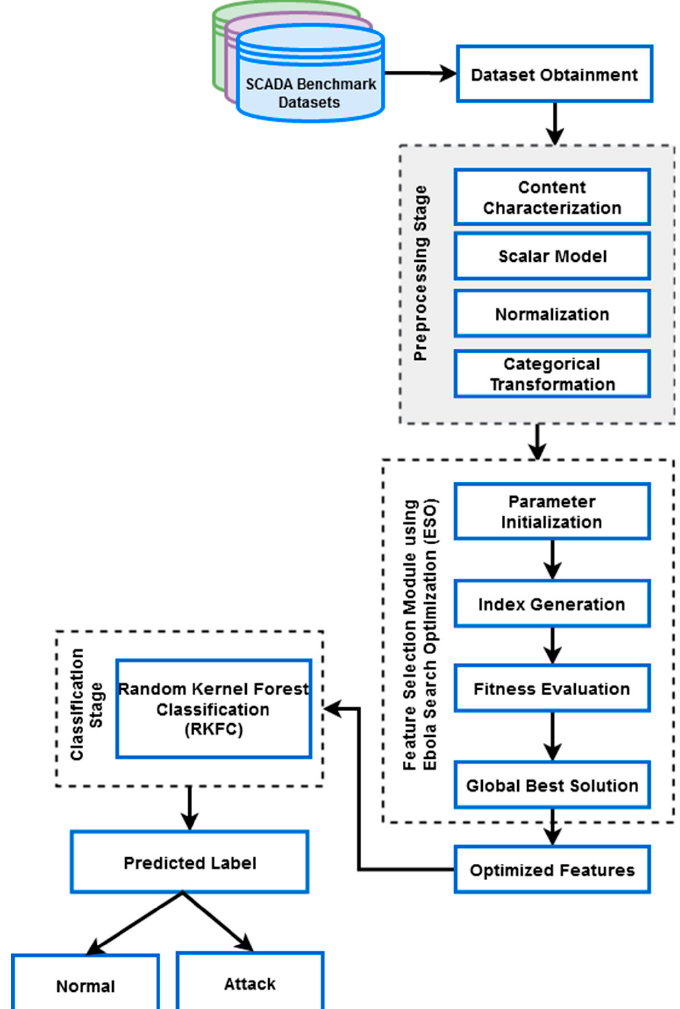
Figure 3. Working flow of the ZESO-RKFC-based security framework. The list of symbols and their descriptions are presented in Table 1.